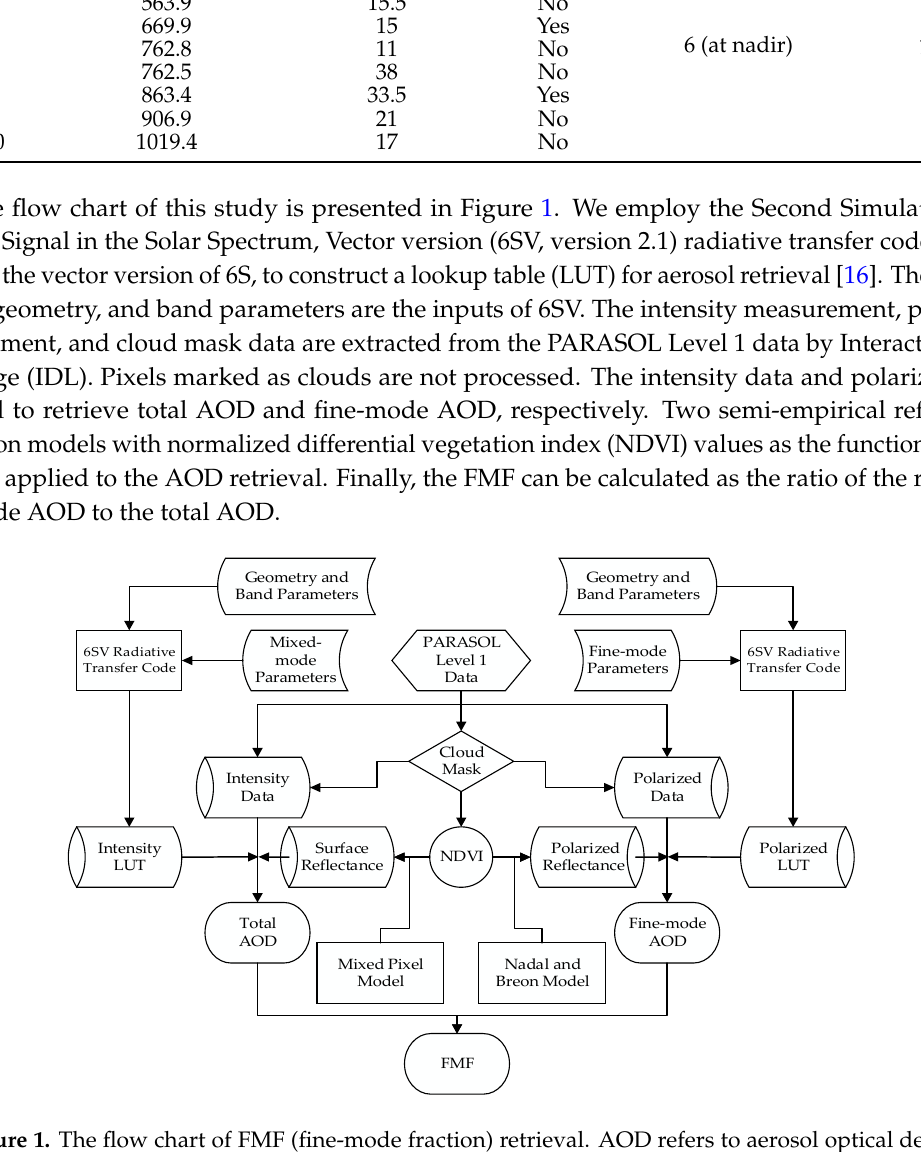
Figure 1. The flow chart of FMF (fine-mode fraction) retrieval. AOD refers to aerosol optical depth. LUT refers to lookup table. NDVI refers to normalized differential vegetation index.